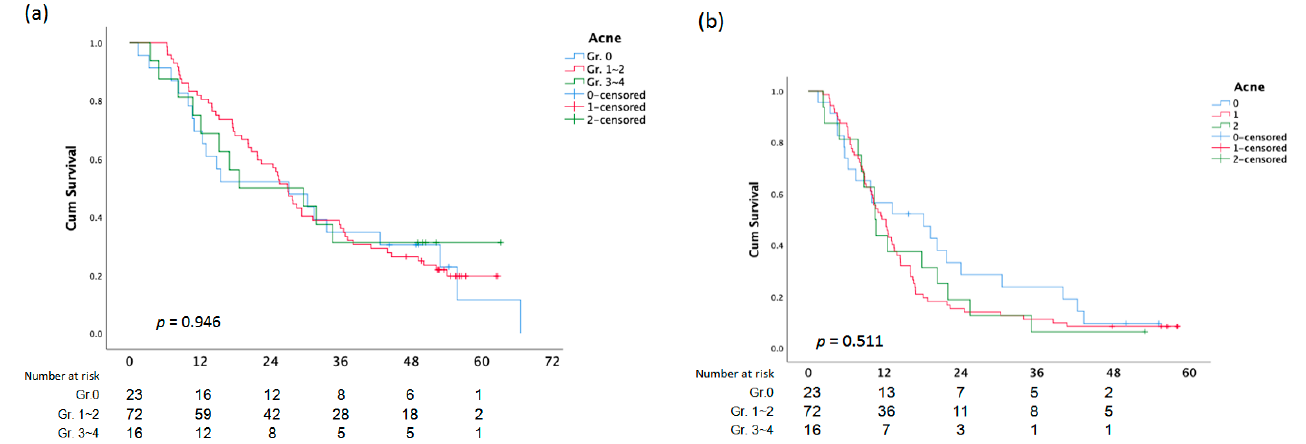
Figure 1. Overall Survival ( a )and PFS ( b ) analysis according to Acne.